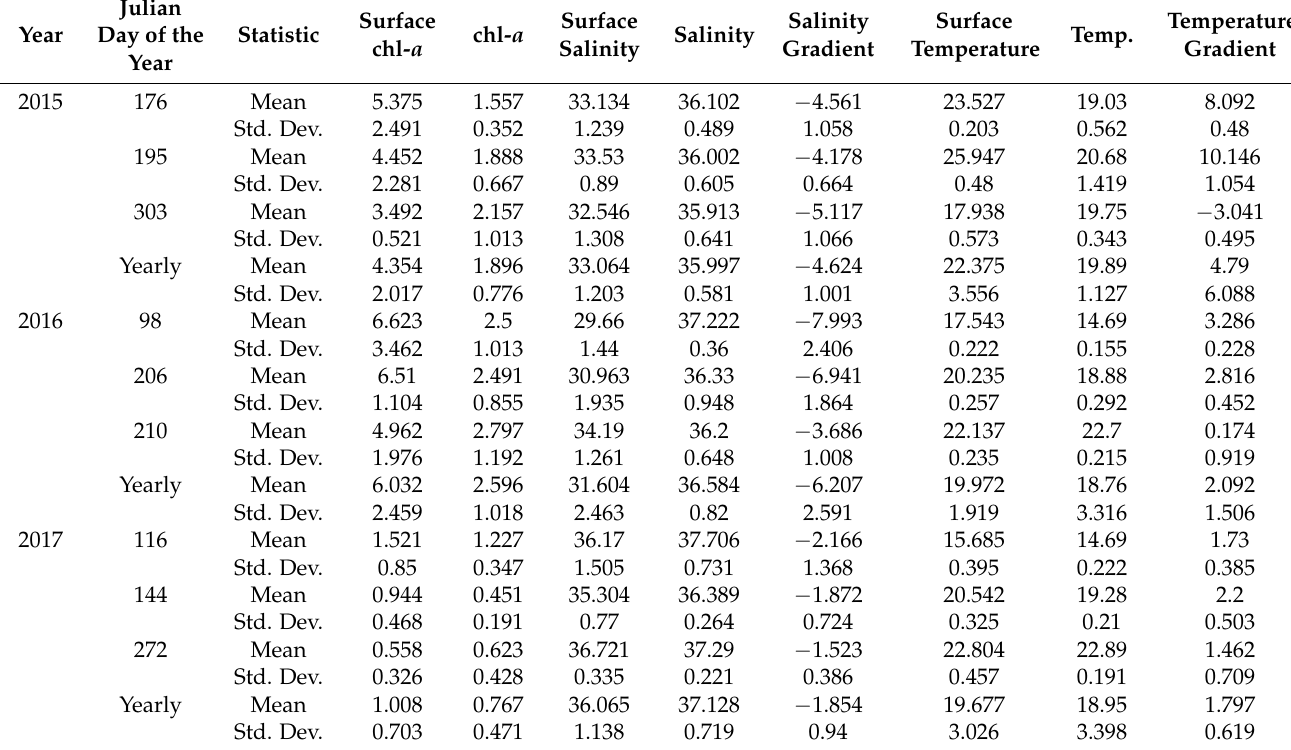
Table 1. Average values for each sampling season and yearly average values of the environmental parameters measured at field sites in the outer Thermaikos Gulf in the Aegean Sea and offshore of the coastal zone of Kitros, in the Pieria region of Greece. During surveys ( N = 140) environmental parameters were recorded at the surface (from 0–5 m depth) and in the water column (>5 m depth to bottom) and used average values, then averaged these across all the sample sites for each category for the